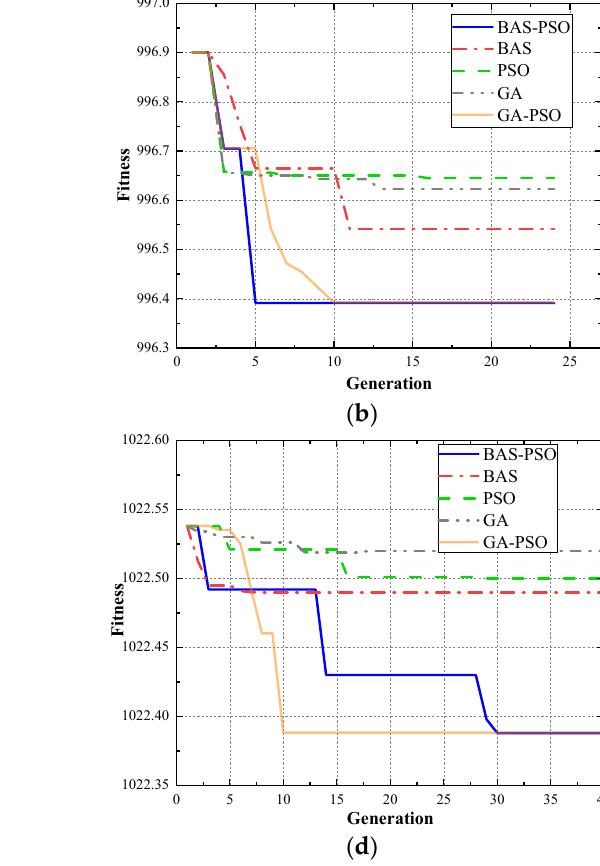
Figure 4. Fitness value of the 10 km/h constant radius test: ( a ) 3° front wheel angle; ( b ) 5° front wheel angle; ( c ) 7° front wheel angle; ( d ) 9° front wheel angle.